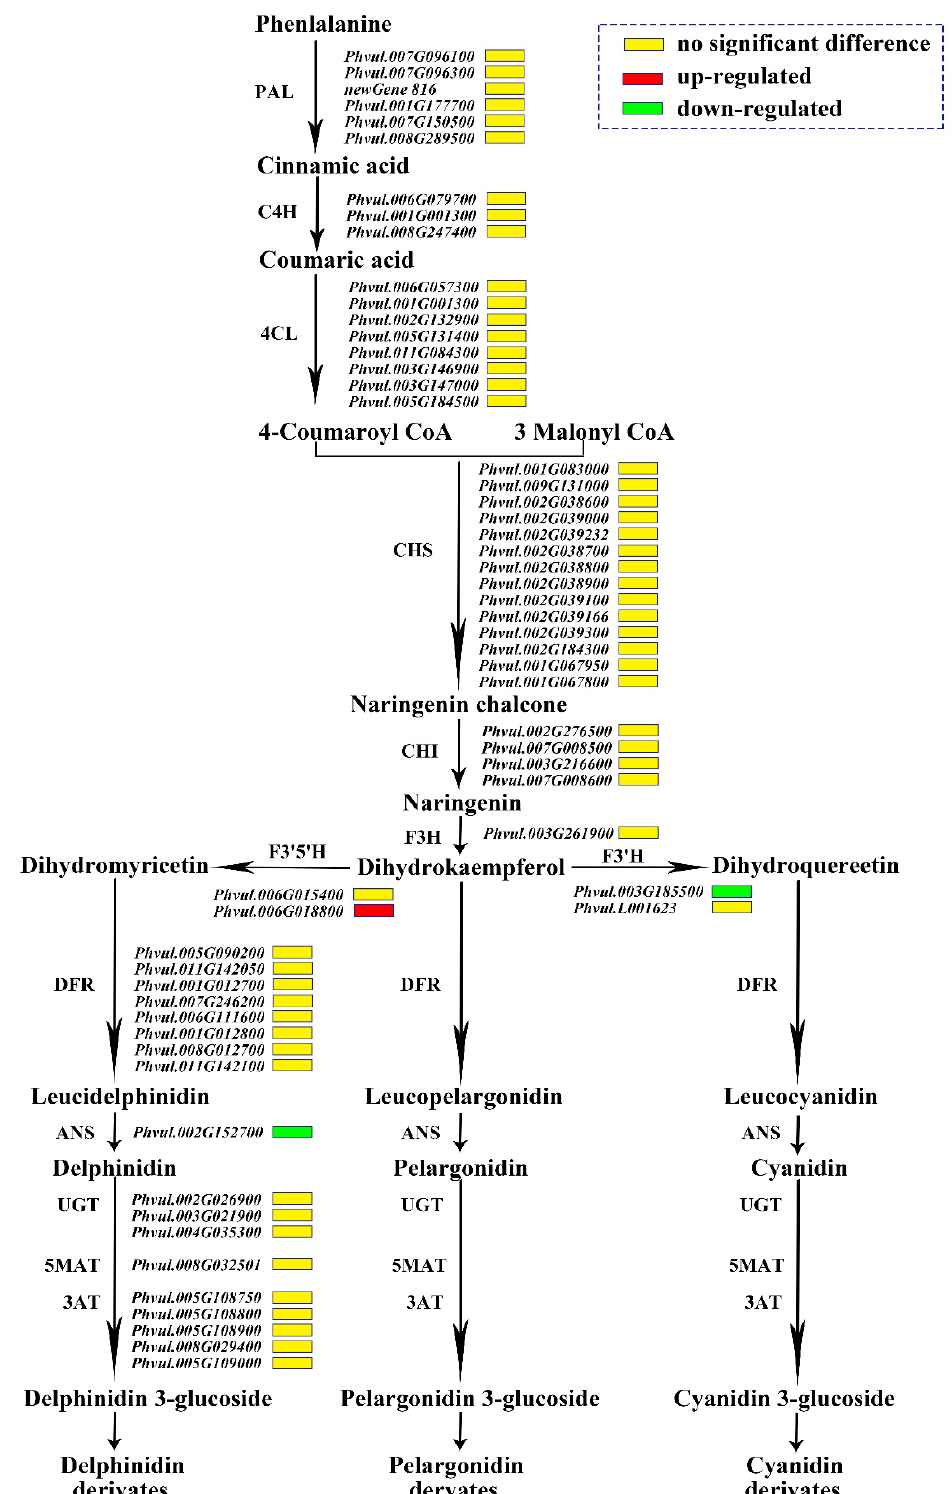
Figure 5. Expression patterns of the genes involved in anthocyanin biosynthesis. Notes: The name of the enzyme is marked on the left of the arrow, and the gene encoding this enzyme is marked on the right of the arrow. The red box represents that the gene is up-regulated in expression in ‘ pv-pur ’, while the green box represents down-regulated expression, and the yellow box represents no significant difference.